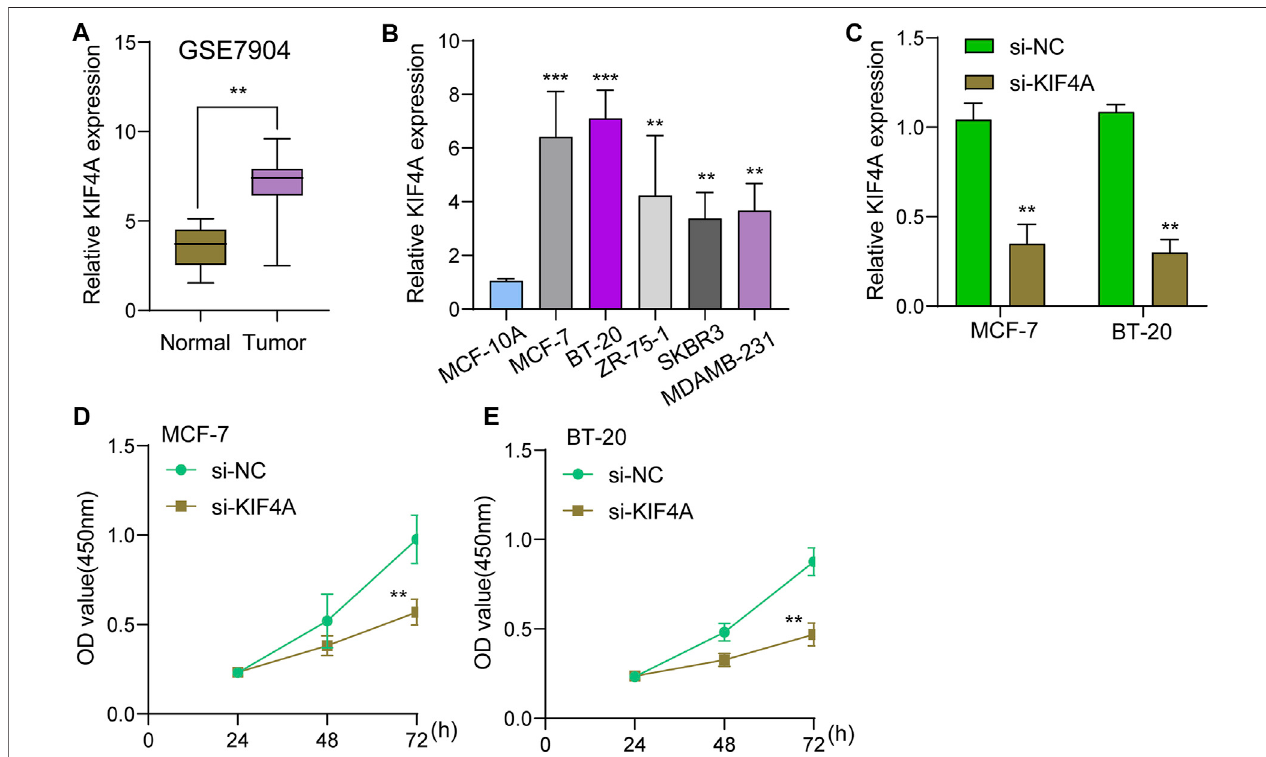
FIGURE 8 | Knockdown of KIF4A suppressed the proliferation of BC cells. (A) The expression of KIF4A in BC sample and normal samples were determined using GSE7904datasets. (B) AnalysisofKIF4AgeneexpressioninBCcelllineswascarriedoutusingqRT-PCR. (C) RT-PCRwasusedtoexamineKIF4AexpressionsinMCF- 7 and BT-20 cellstransfectedwithsi-NC or si-KIF4A. (D,E) CCK8 assaysfor the assessment ofthe effect ofKIF4A knockdown onthe proliferationofMCF-7 and BT-20 cells. ** p < 0.01, *** p <